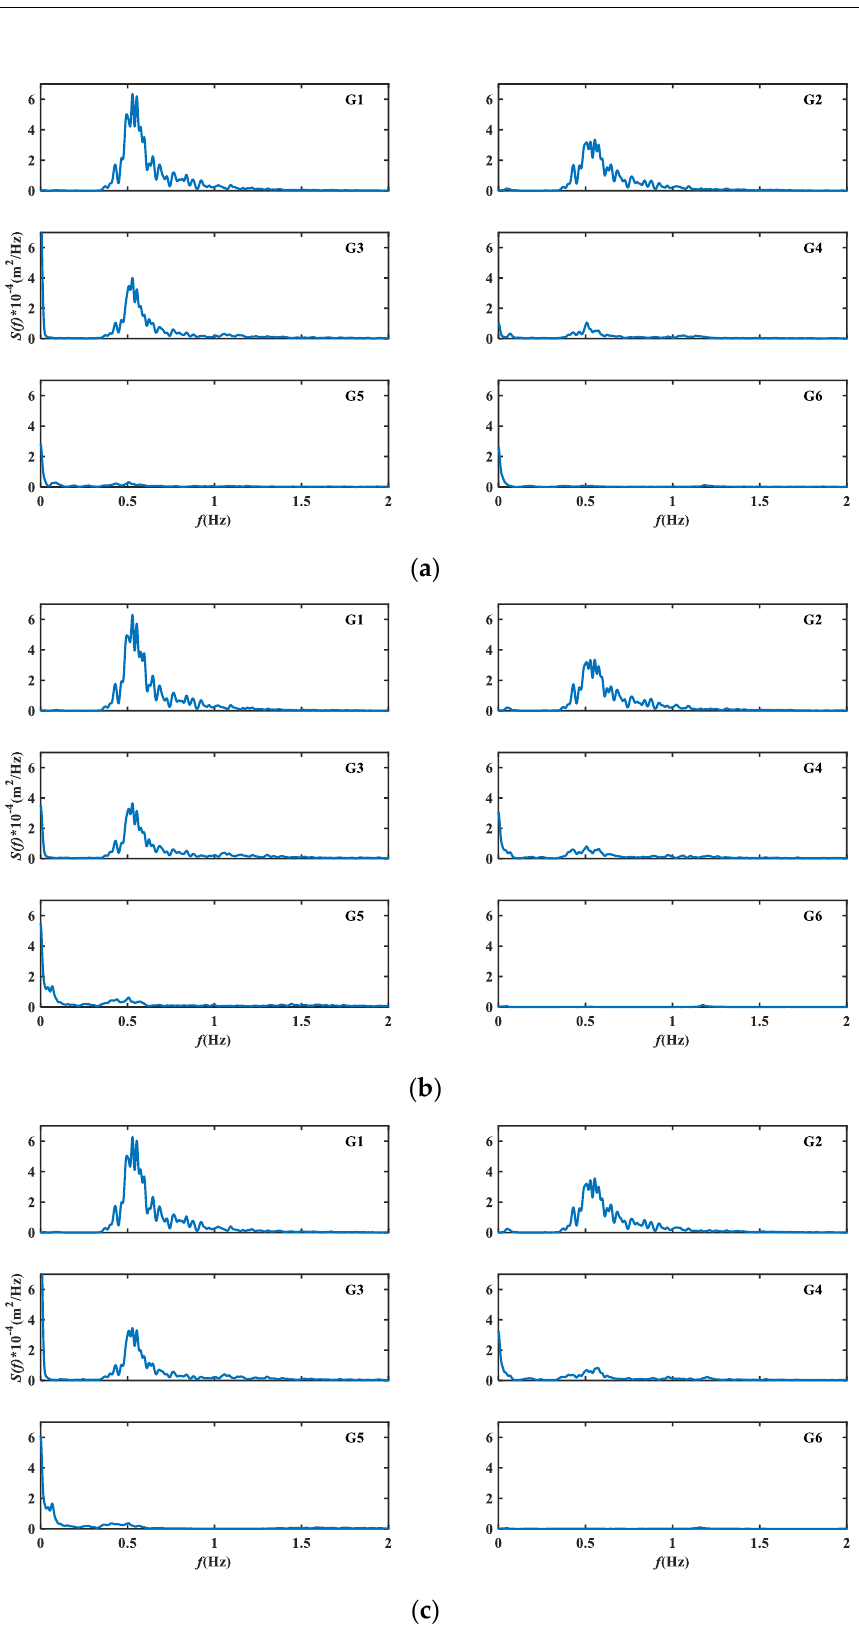
Figure 14. Variations in irregular wave spectra across the reef for H s 0 = 0.1 m, T 0 = 1.4 s, cot θ = 3, l = 3 m, and h r = 0.05 m: ( a ) without seawall; ( b ) vertical seawall; ( c ) sloped